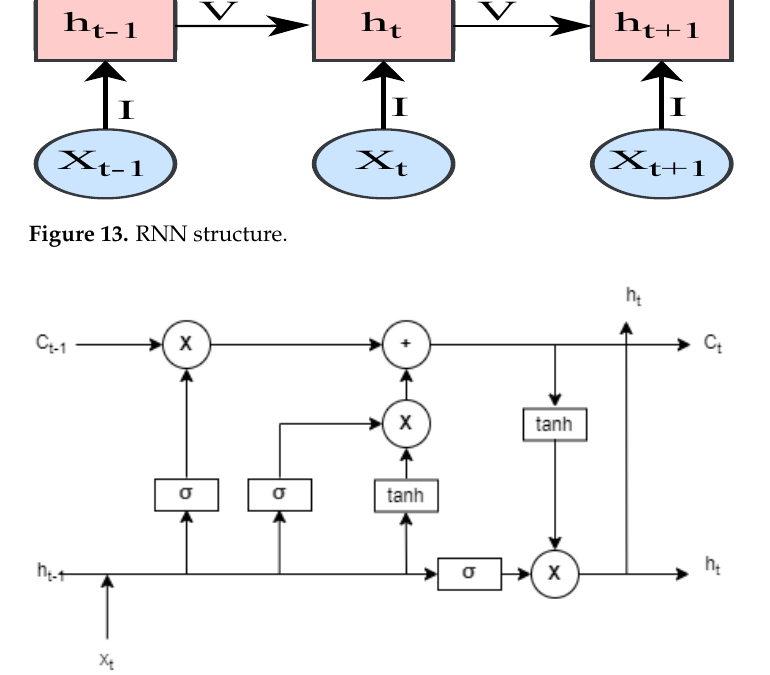
Figure 14. LSTM Cell Design.